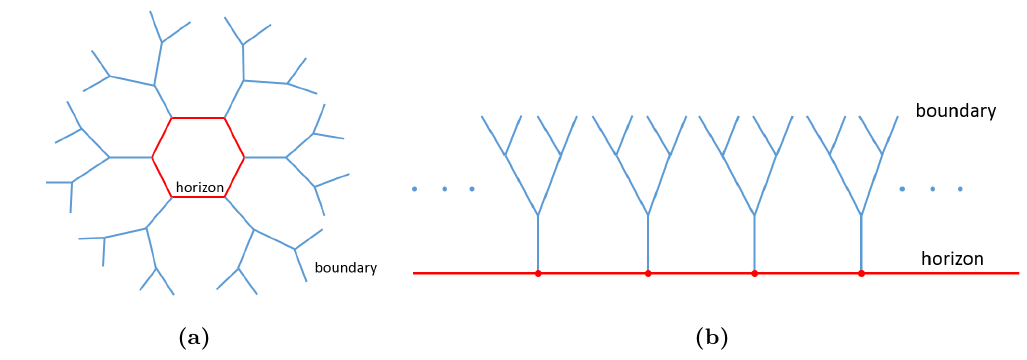
Figure 4. (a): the p-adic BTZ BH, (b): the cylinder type p-adic BH. The red curve is the